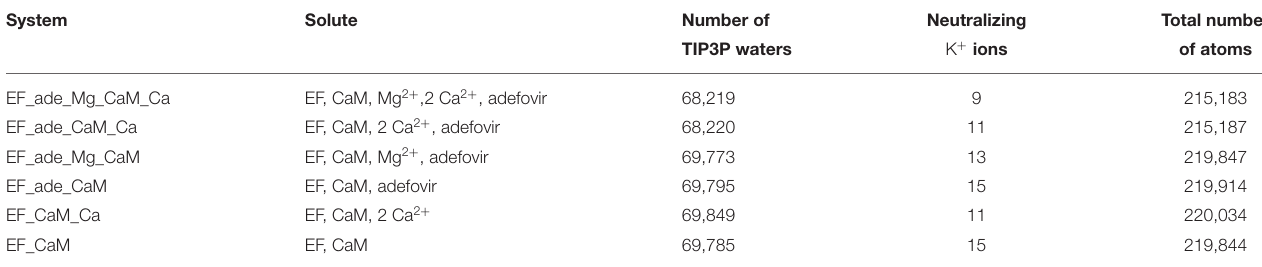
TABLE 1 | Systems